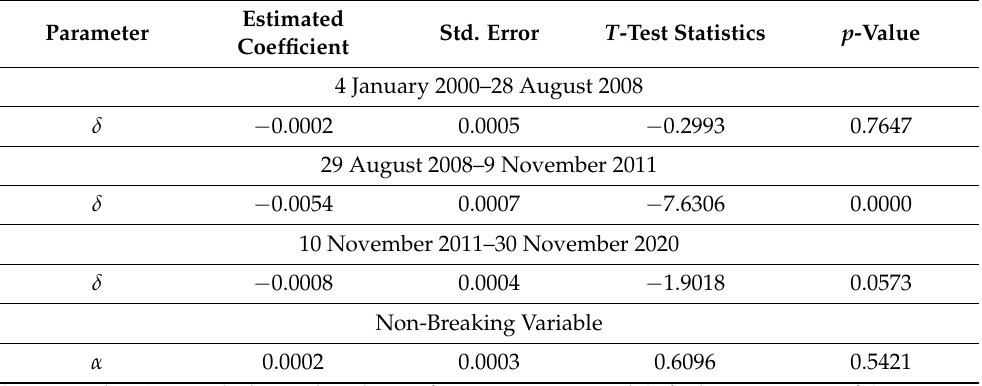
Table 5. Regression model (5) with sequential Bai–Perron test for structural breaks for the S&P Sugar Index and the S&P 500 Realized Volatility